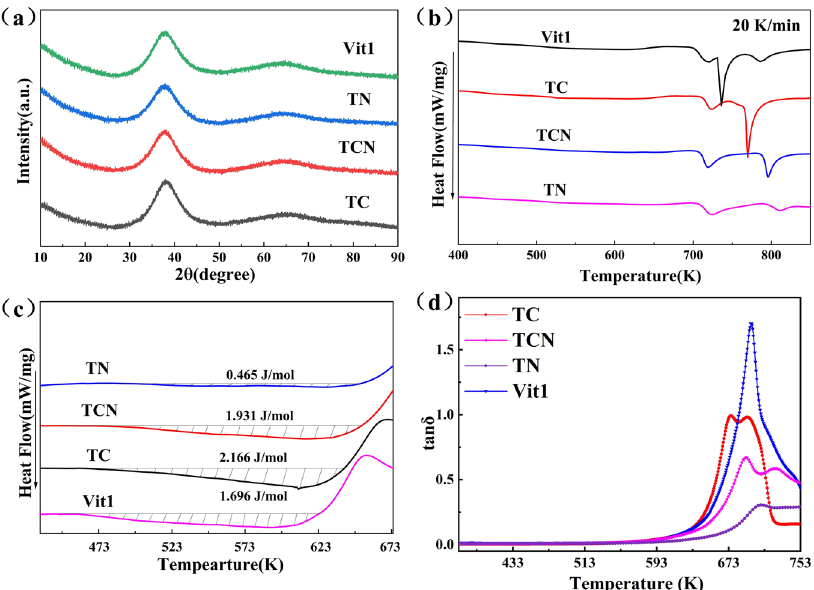
Fig. 1 The structures and dynamic mechanical analysis results of the samples. a XRD spectra, b DSC curves, c relaxation enthalpies, and d loss factors ( tan δ ¼ E 0 = E 00 ) with a fi xed frequency of 1 Hz and a constant heating rate of 5